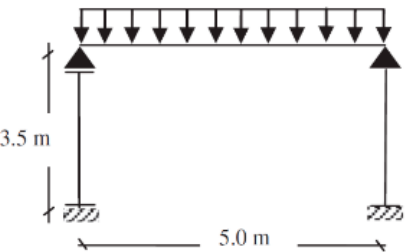
Figure 6. Simplified overview of a columns-supported isostatic beam. Table 4. Results of the frame sections design.